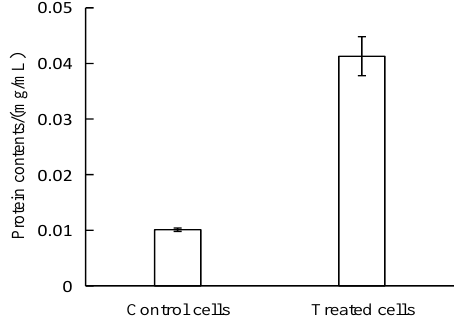
Figure 4. Effect of APLTP on E. coli protein content.